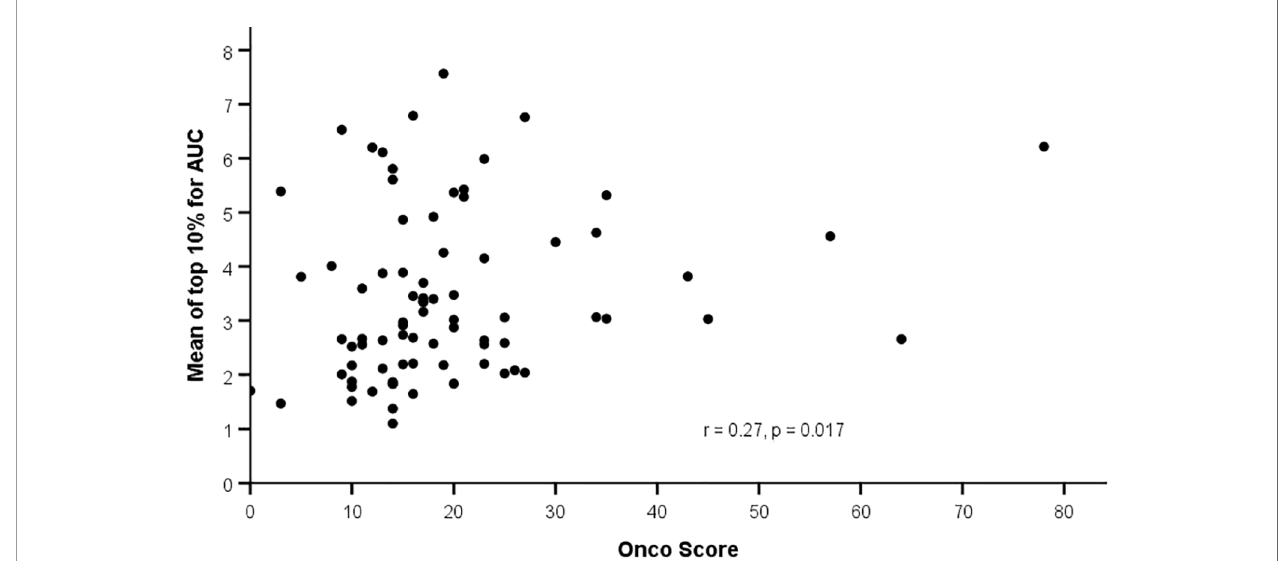
FIGURE 2 | Correlation between background parenchymal enhancement (mean top 10%) and Oncotype Dx Recurrence Score.